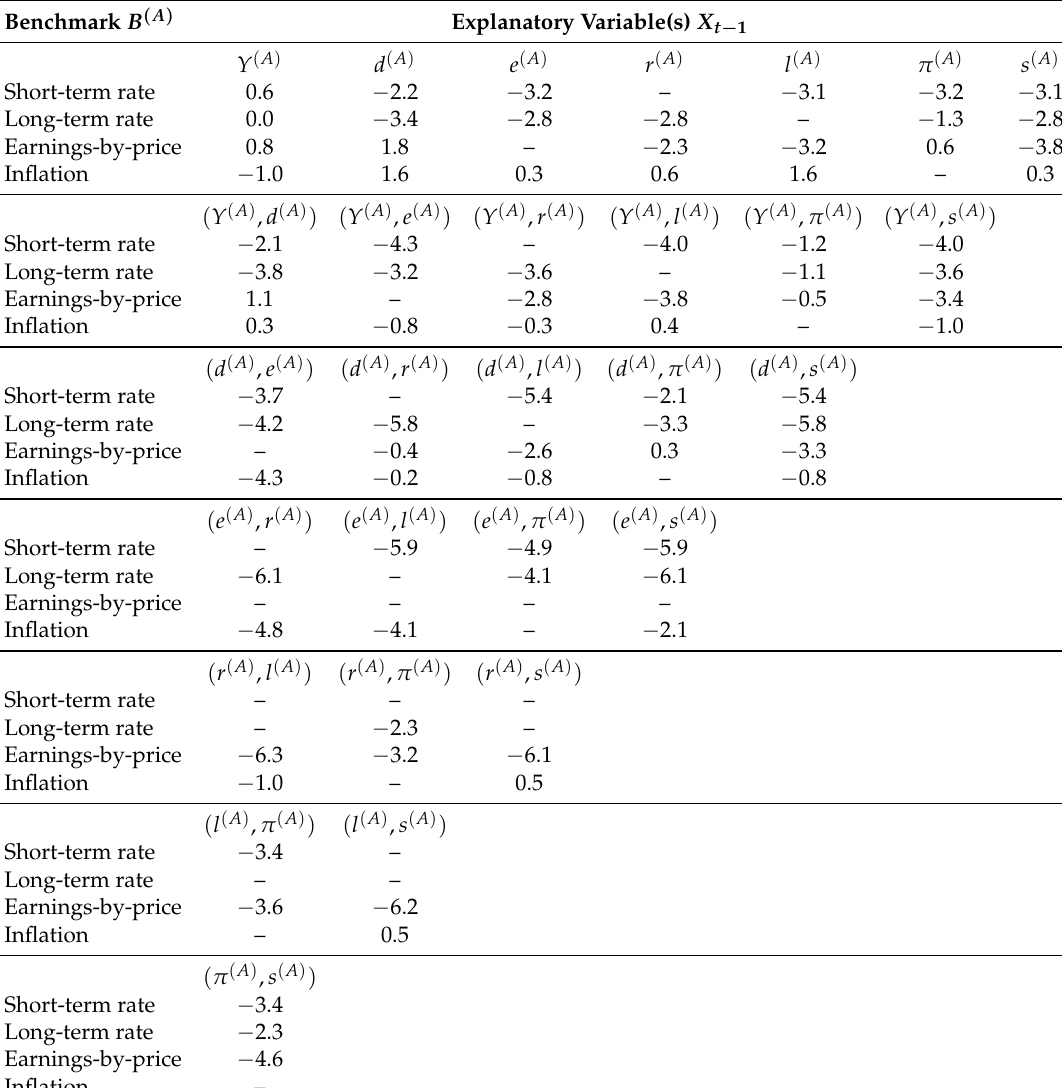
Table 5. Predictive power for the variance of five-year excess stock returns Z benchmarking approach. The prediction problem is defined in (15). The same predictive variables X are used in the predictions for the conditional mean and variance. Additional notes: see Table